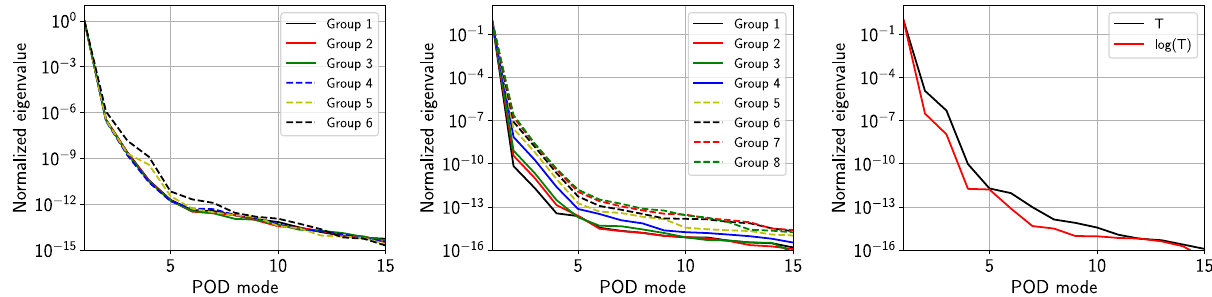
Fig. 2. The decay in the eigenvalues of correlation matrices for the neutron flux (left), precursor concentration (middle) and temperature (right).